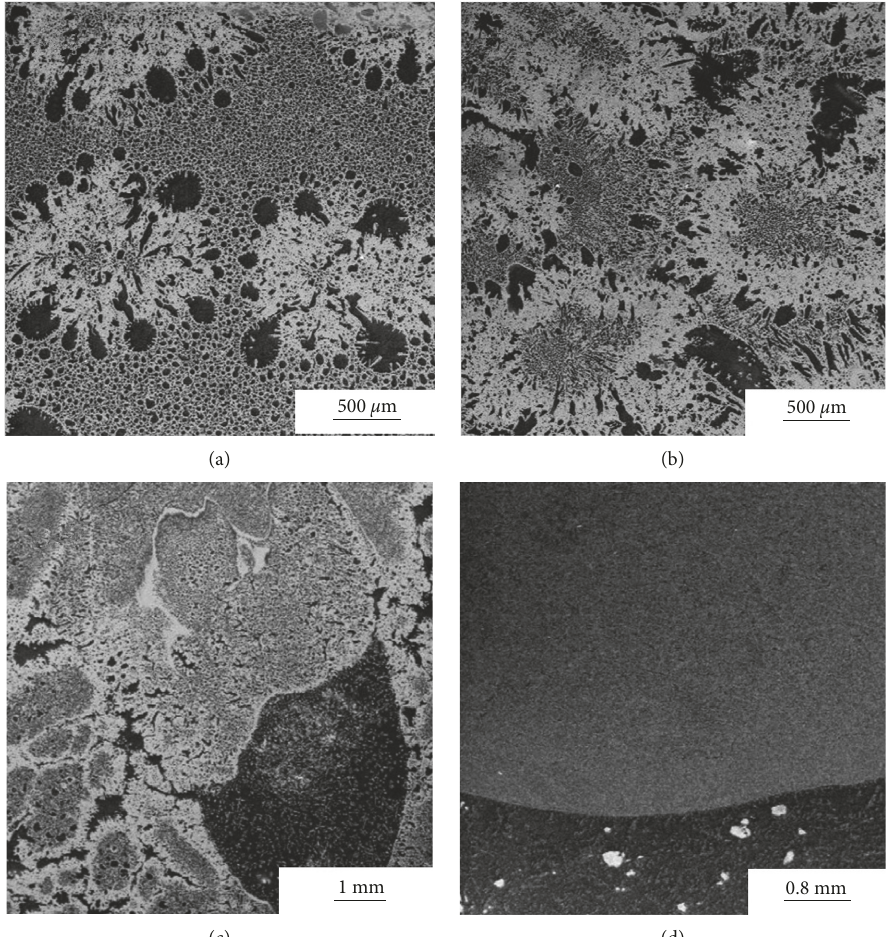
Figure 5: Microstructures of Cu-40 wt.% Pb hypermonotectic alloy under different degrees of undercooling: (a)